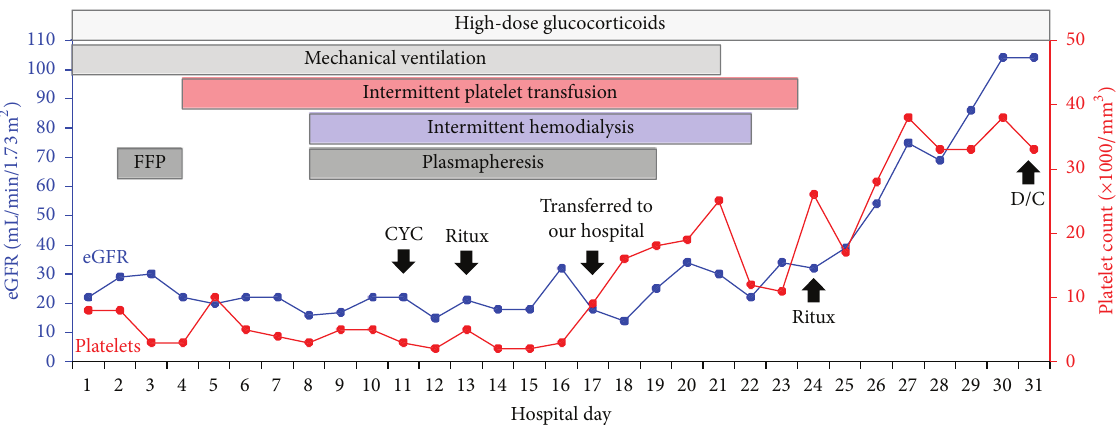
Figure 1: Renal function, platelet count, and therapeutic interventions during hospitalization. The estimate glomerular filtration rate (eGFR) is calculated using MDRD formula. Boxes represent the type and duration of specific treatments. See text for details. CYC: cyclophosphamide: D/C, discharged home; Ritux: rituximab.